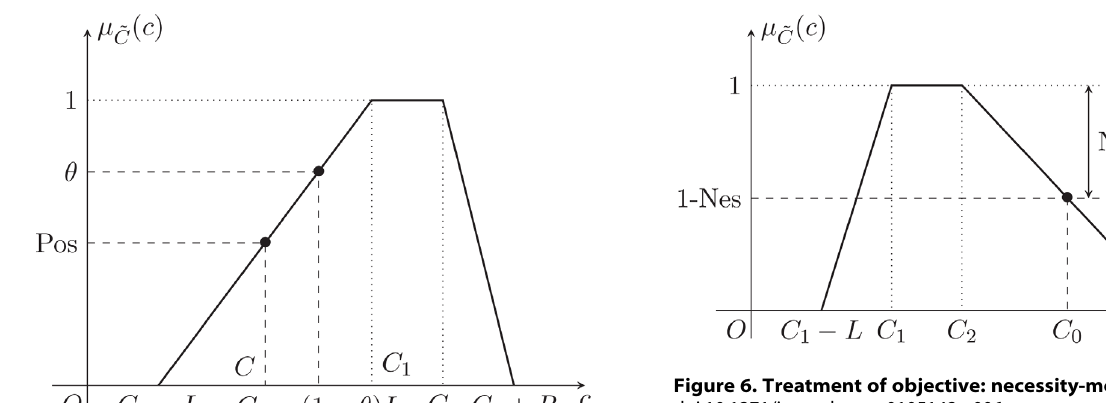
Figure 6. Treatment of objective: necessity-modality approach.